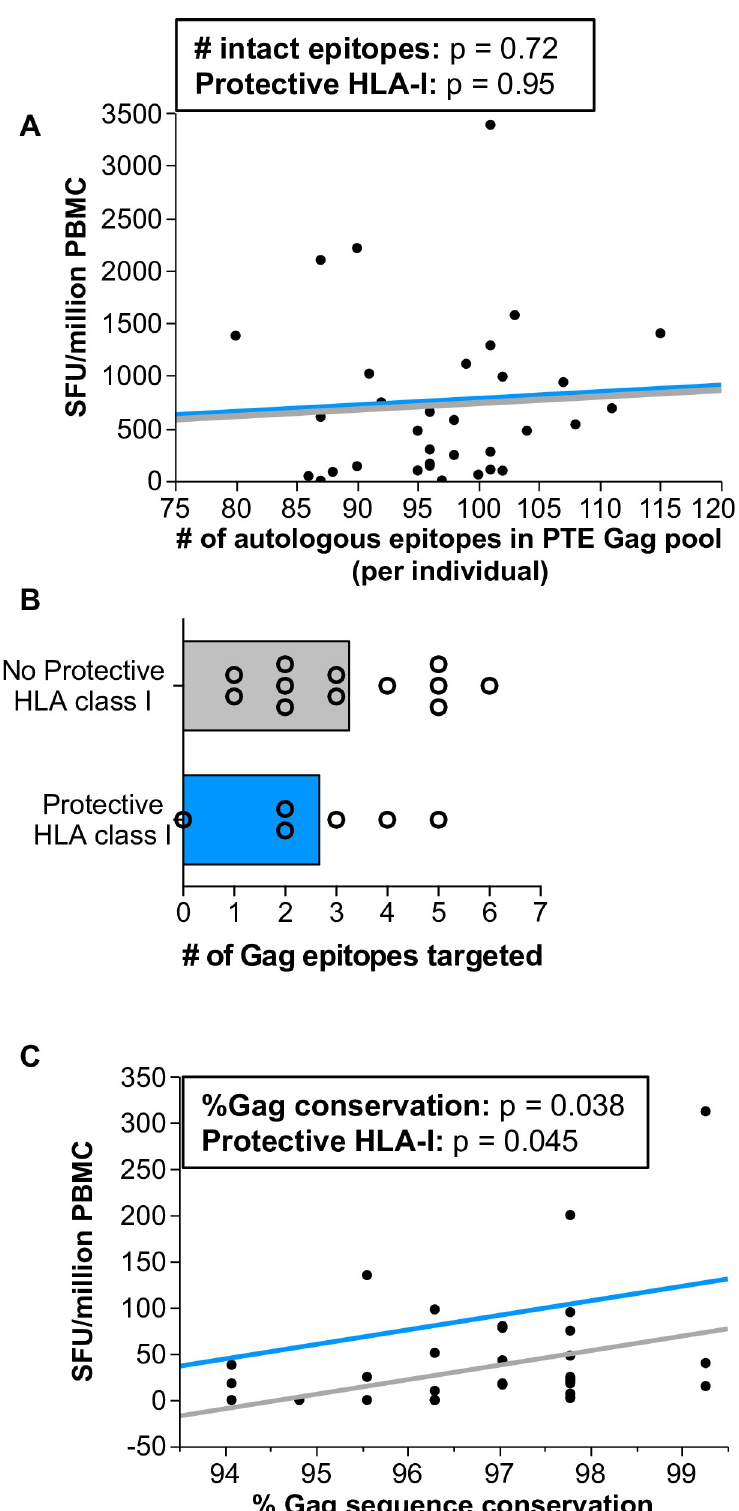
Fig 6. Individuals with CD4-protective HLA class I alleles more efficiently target conserved regions of Gag. (A) A graphical depiction of a generalized linear model showing the relative association between the presence of CD4-protective HLA class I alleles with IFN γ ELISpot responses to Gag PTE peptide pools from cryopreserved PBMCs